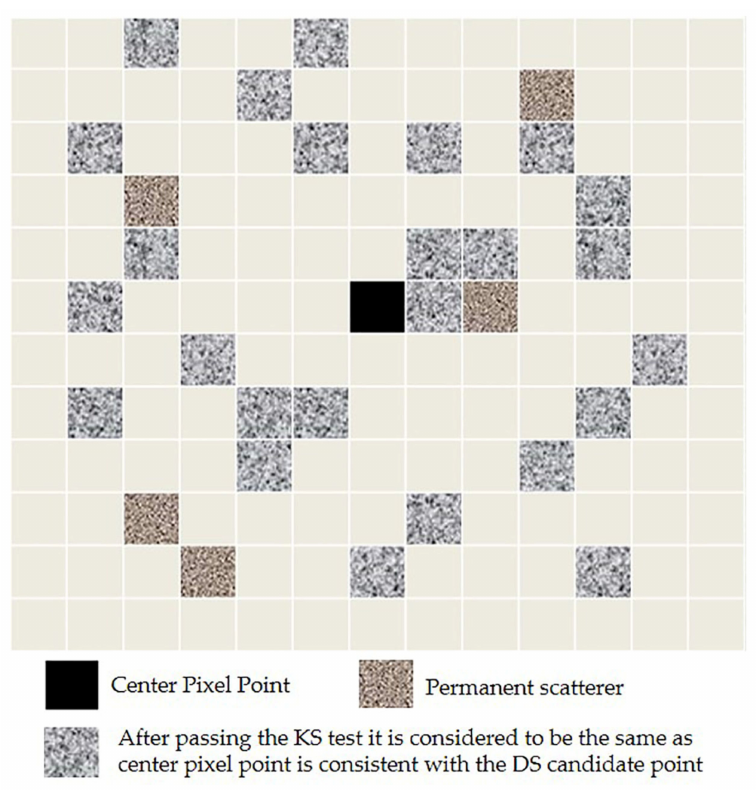
Figure 2. Pixel identification information within the search window (12 × 13) obtained based on KS